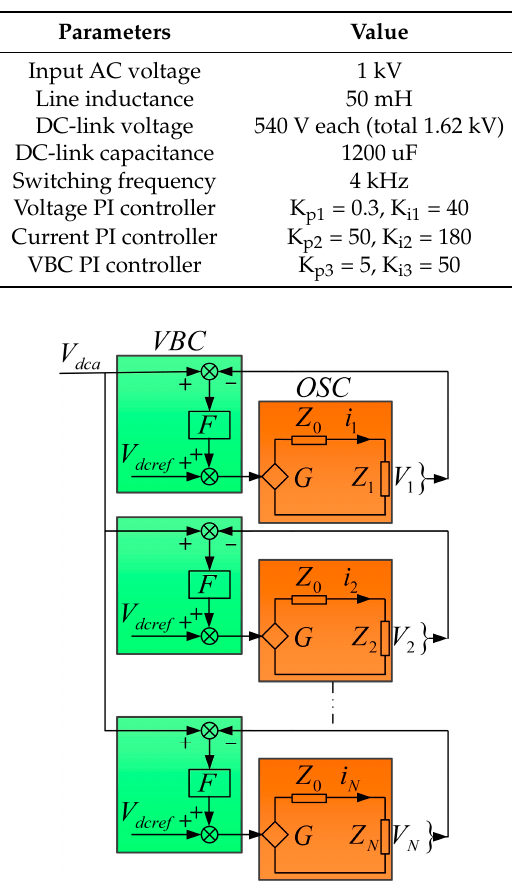
Figure 6. Thevenin equivalent circuit of the CHBR.